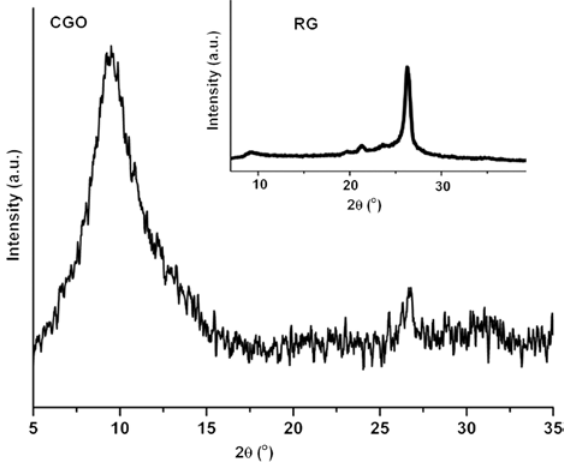
Figure 1: XRD of CGO; inset is of RG.